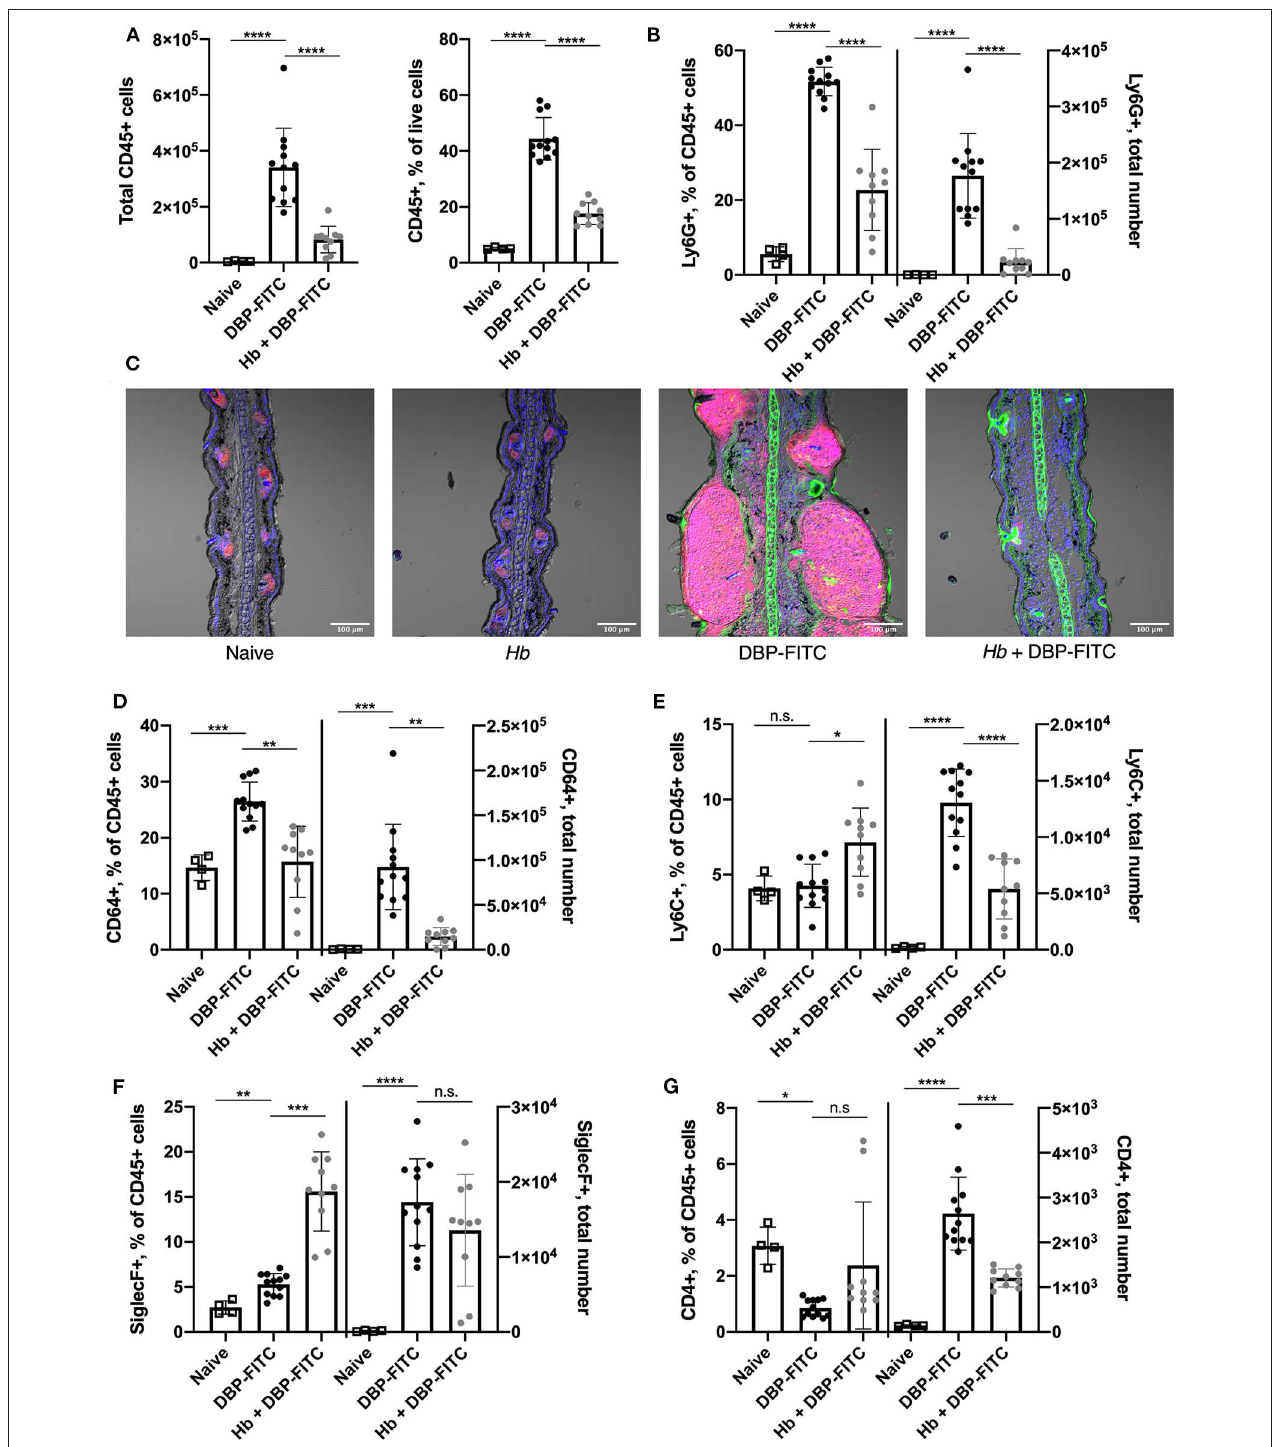
FIGURE 5 | Prior Hb infection limits influx of innate inflammatory cells after DBP-FITC challenge. (A) Total number of CD45 + cells and their frequency within all live cells in the skin tissue at day 7 (24h after DBP-FITC challenge). (B) Frequency within CD45 + cells, and total number of neutrophils (Ly6G + ) in the skin at day 7. (C) . Immunofluorescent staining of ear sections taken at day 7. Ly6G + neutrophils (pink), FITC (green) and DAPI (blue). Scale bar represents 100 um. (D) Frequency within CD45 + cells and total number of macrophages (CD64 + ), (E) monocytes (Ly6C + ), (F) eosinophils (SiglecF + ), and (G) CD4 + T cells in the skin at day 7. A one-way ANOVA with Tuckey’s multiple comparisons test was used to test statistical significance. Graphs represent data combined from 2 experiments and show mean ± SD. n.s, not significant; * p < 0.05, ** p < 0.01, *** p < 0.001, **** p < 0.0001.